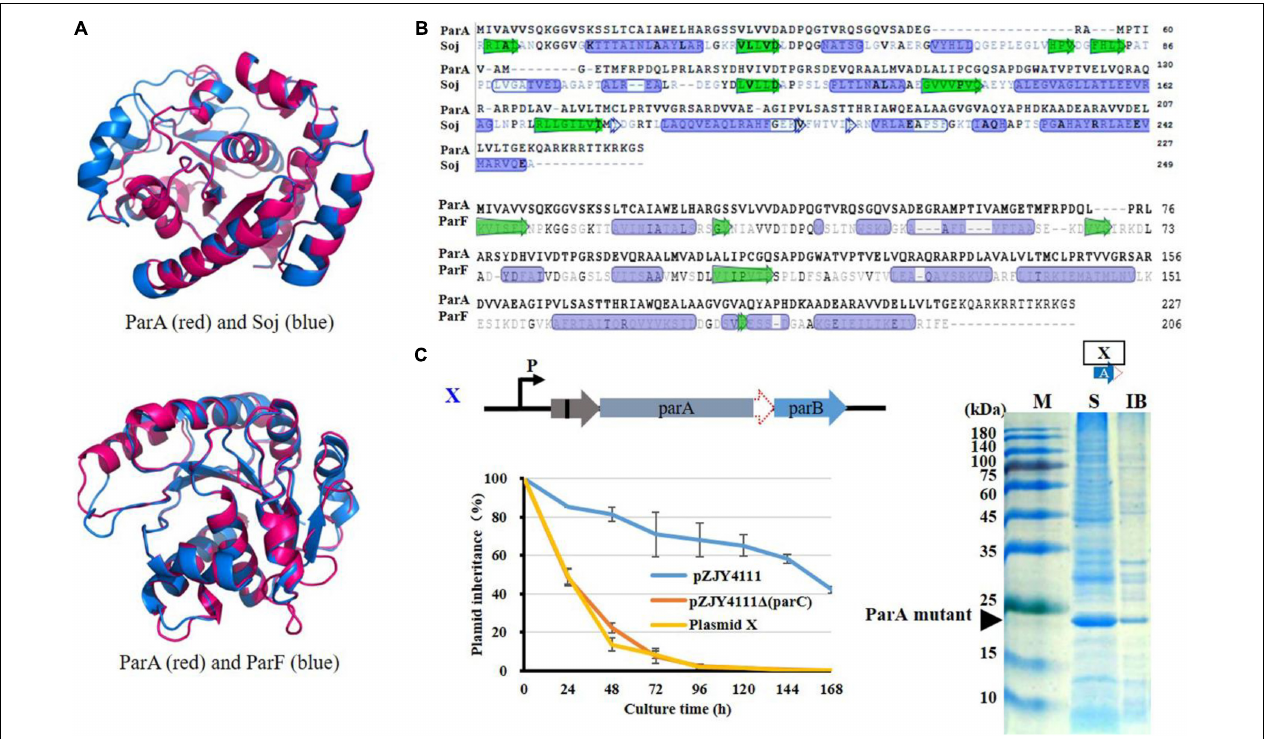
FIGURE 4 | Analysis on structural and functional characteristics of ParA. (A) Structural and (B) sequence comparison of ParA with Soj of T. thermophilus (Leonard et al., 2005) or ParF of S. newport TP228 plasmid (Schumacher et al., 2012). Protein structure was predicted with I-TASSER (https://zhanglab.ccmb.med.umich. edu/I-TASSER) (Yang et al., 2015). In the structure comparison, ParA is shown in red and Soj or ParF is shown in blue. (C) Deletion of 42 C-terminal bases (14 amino acids) of parA of the parCAB operon in pZJY4111 (cid:49) parC (plasmid XI). Inheritance stability of plasmid XI was assayed in M. xanthus DZ1. Error bars indicate the SD of four or six independent experiments. Expression of the ParCA fusion proteins was performed in E. coli BL21(DE3) cells by using pET15b. ATPase activity was assayed of the ParCA fusion protein. M, protein standard; S, supernatant; IB, inclusion